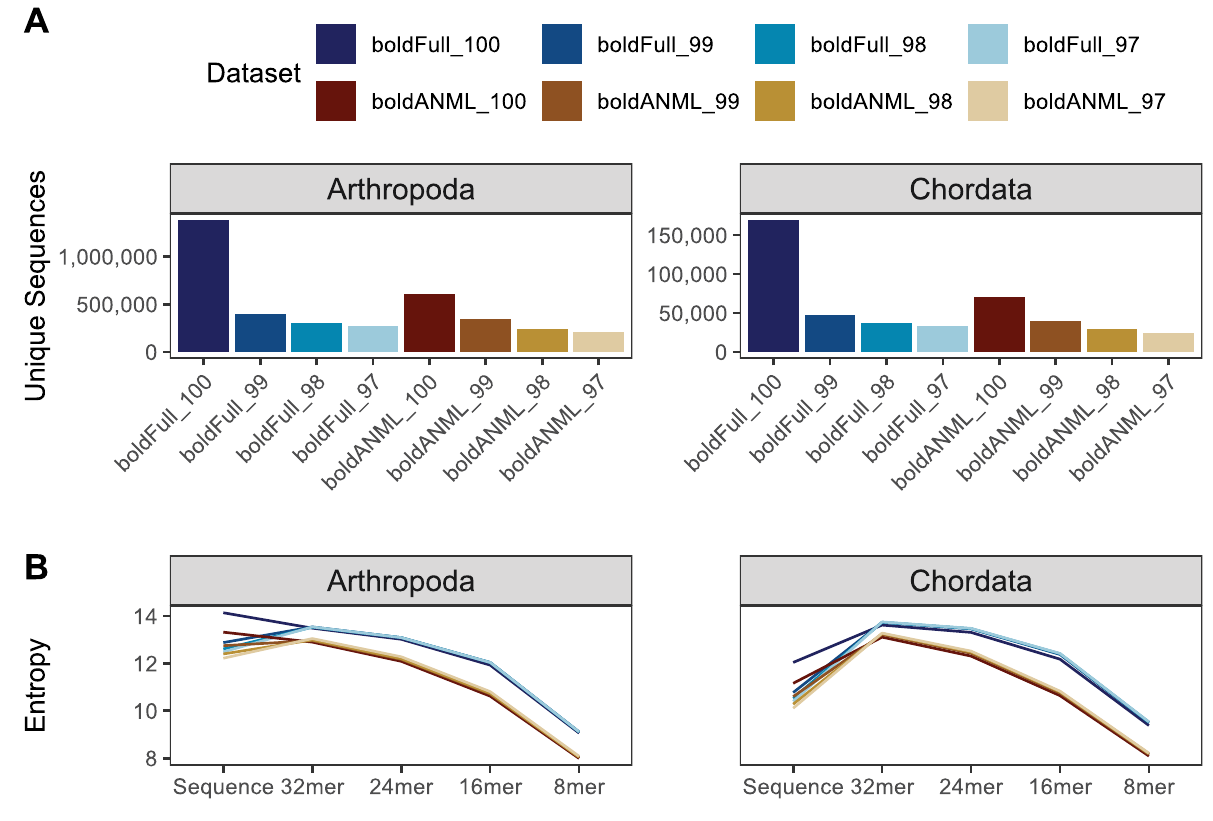
Fig 10. Comparison of sequence information from BOLD COI gene database for available arthropod and chordate sequences. Differences in datasets reflect whether sequences were trimmed to a particular primer region (boldANML) or not (boldFull), and whether sequences were dereplicated (100) or clustered at a particular percent identity (97, 98, 99). A, Number of unique sequences. B, Entropy of sequences and different kmer lengths.